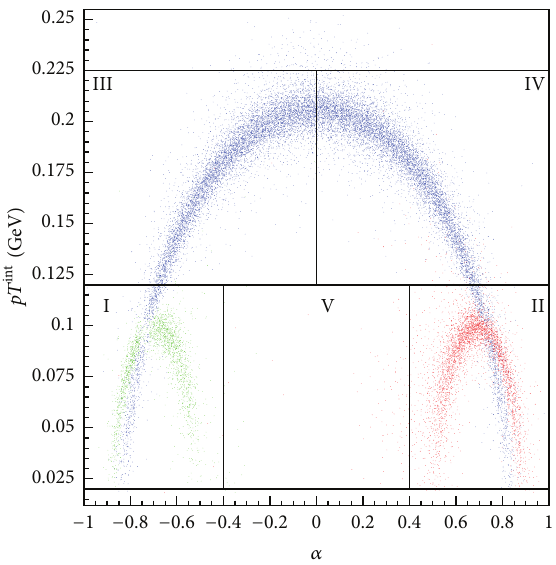
Figure 11: Plot of 𝑝 int 𝑇 versus 𝛼 identifying the populations of 󸀠 strange particles (from [22]). Λ s and Λ 󸀠 s populate boxes I and II, respectively. The 𝐾 ∘ 𝑠 sample being symmetric is found in all boxes except box V. Photon conversions populate the small 𝑝 int 𝑇